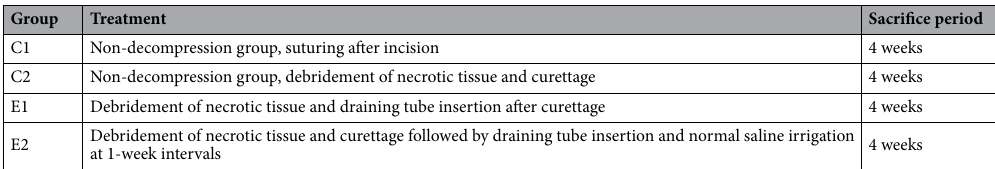
Group Treatment Sacrifice period C1 Non-decompression group, suturing after incision 4 weeks C2 Non-decompression group, debridement of necrotic tissue and curettage 4 weeks E1 Debridement of necrotic tissue and draining tube insertion after curettage 4 weeks E2 Debridement of necrotic tissue and curettage followed by draining tube insertion and normal saline irrigation at 1-week intervals 4 Table 1. Animal grouping. The animals were divided into control groups (C1 and C2) and experimental groups (E1 and E2). CFU Colony Forming Unit.